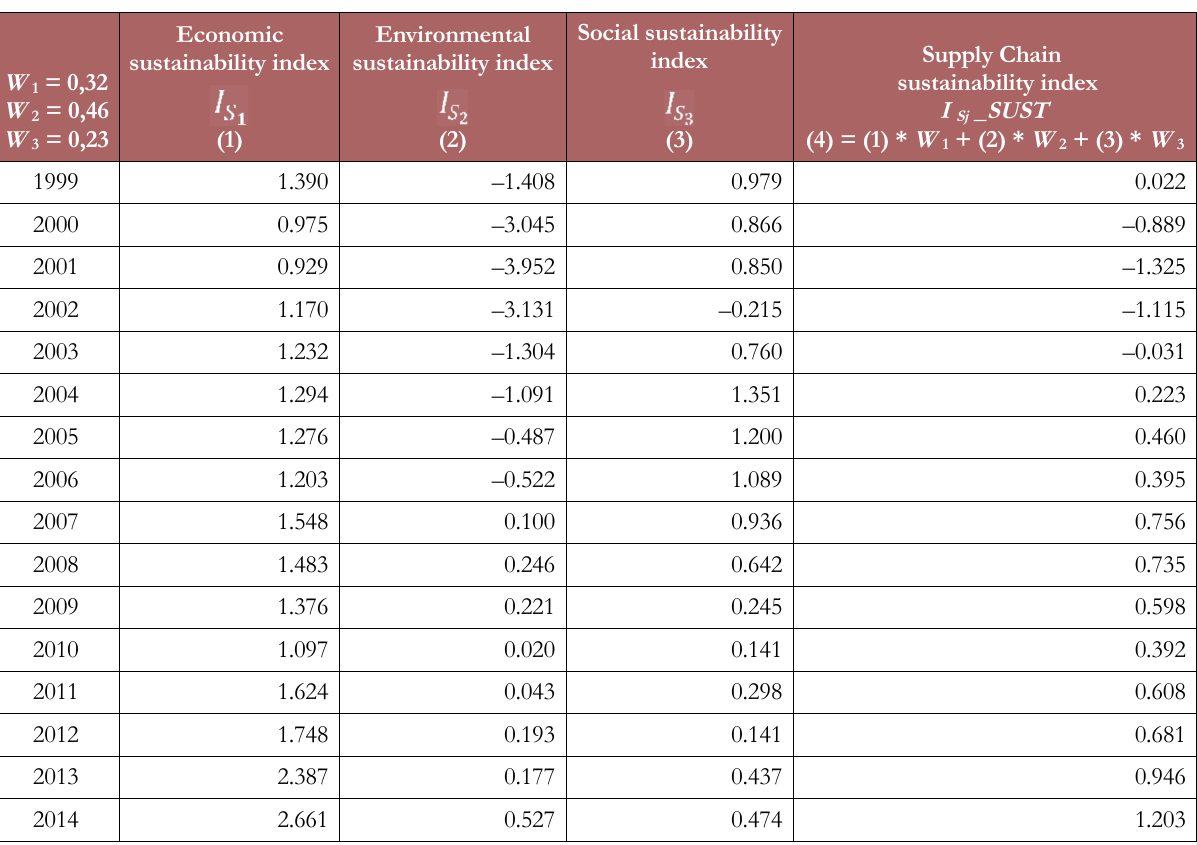
Table 8. Supply chain sustainability